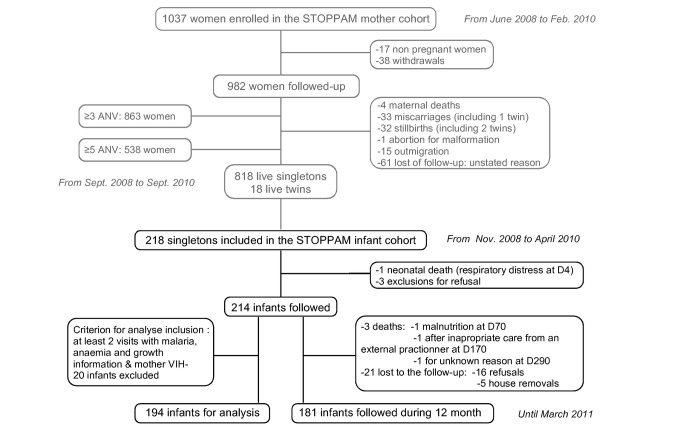

Figure 2. Flowchart diagram of STOPPAM follow-up: Infants who were absent during ≥4 months, and not seen before their 12 months were considered as lost to follow-up (5 home removal and 16 refusal). For each, the field team checked that it was not due to medical reasons. Mothers of infants lost to follow-up were younger than the others, but all other characteristics were similar.
Four infants died during the follow-up: one perinatal death after a respiratory distress syndrome, and 3 after more than 28 days, due to severe malnutrition and respiratory infection. None of those infants was premature, born with a low birth weight, or had any distinctive characteristics from the others. Twelve infants who poorly took part to the follow-up (less than 2 visits with information on malaria and anaemia) were excluded from the analyses. Because of HIV test shortage, 8 mothers were not tested and their infant was also excluded from the analyses.